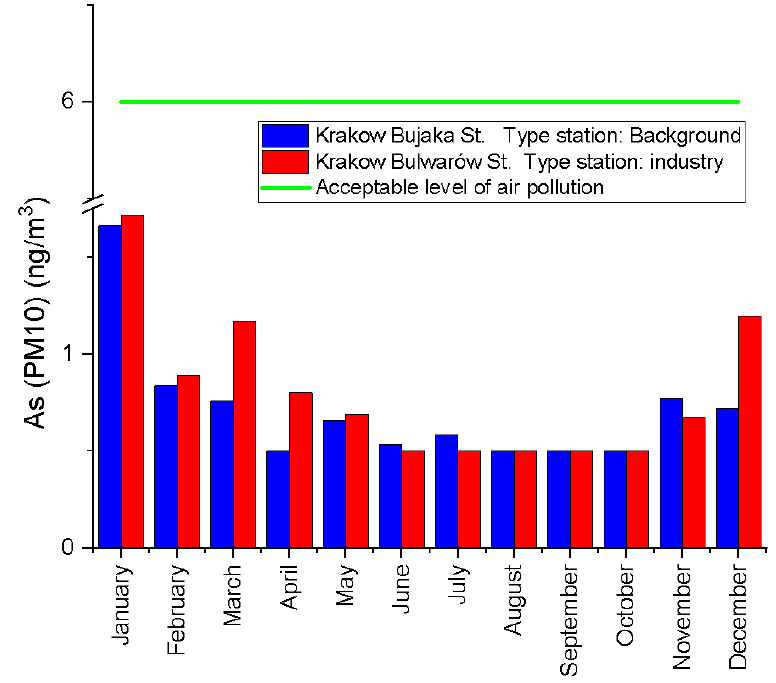
Figure 7. Average concentration of As (PM10) in individual months of 2020. Differently, the highest concentration of Ni was recorded in October at the station Bulwarów Str., with a value of 2.34 ng m − 3 , while the lowest was in February at the station Bujaka Str., with a value of 0.67 ng m − 3 at the permissible concentration of 20 ng m − 3 (Figure 8).